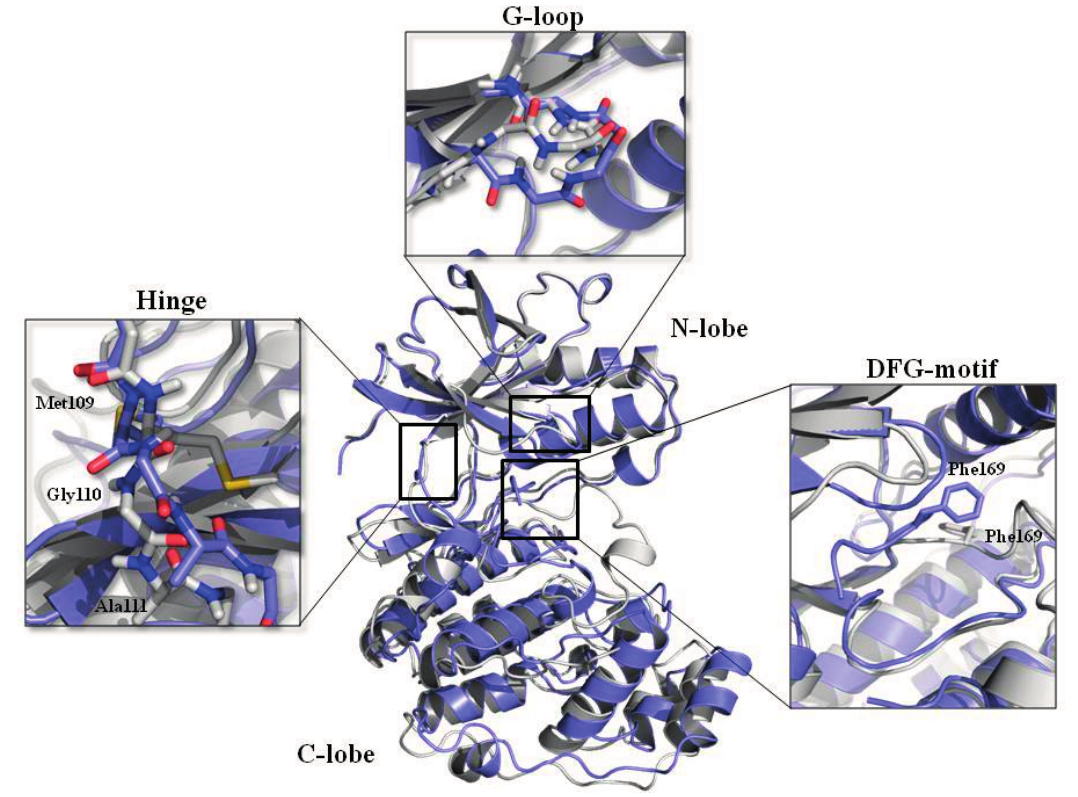
Figure 4. Superimposition of the two structures possessing the lowest (3HP2, purple ) and highest (1W84, white ) ATP binding site volume. The main protein regions involved in conformational changes are highlighted in the respective